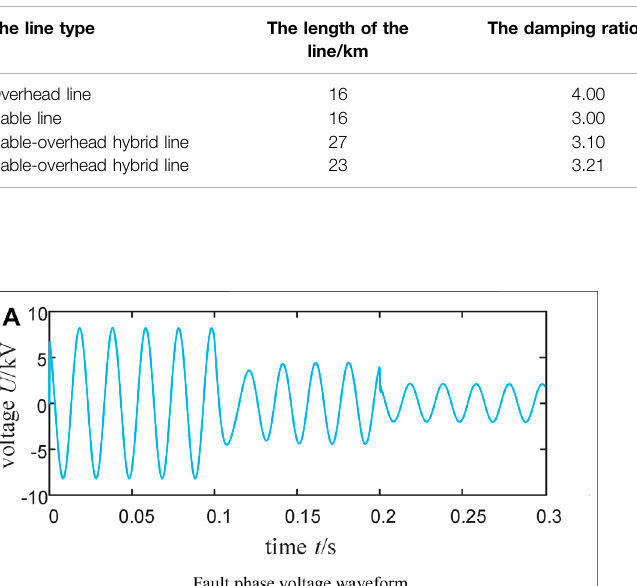
TABLE 2 | Circuit parameters.